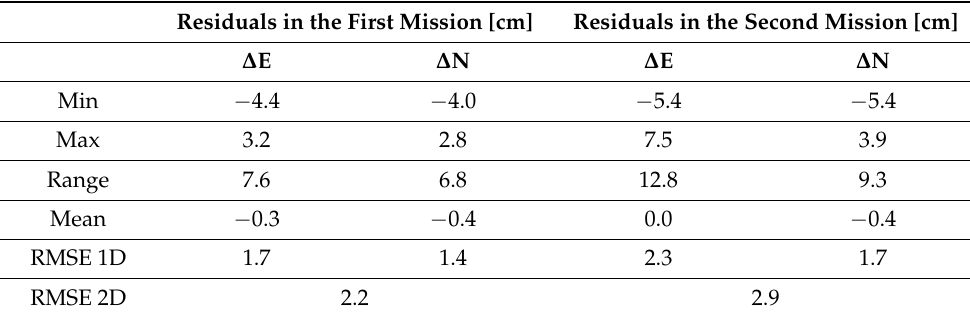
Table 7. Statistics of residuals between the referent displacement vectors and vectors determined from orthomosaic images and RMSE of determining displacements from orthomosaic images. Residuals in the First Mission [cm] Residuals in the Second Mission [cm] ∆ E ∆